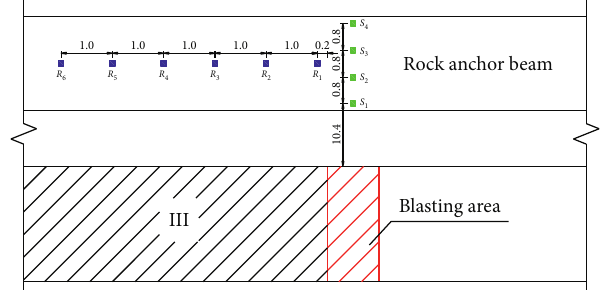
Figure 17: The monitoring points of rock anchor beam concrete (unit: m).